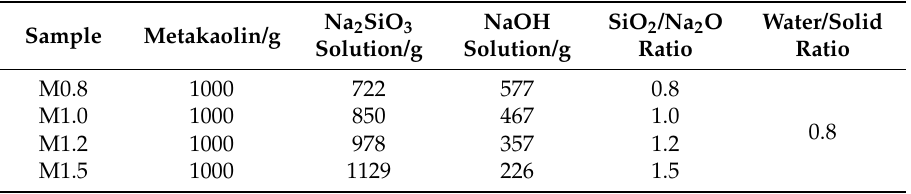
Table 2. Mixtures of geopolymer coating with different ratios of SiO 2 /Na 2